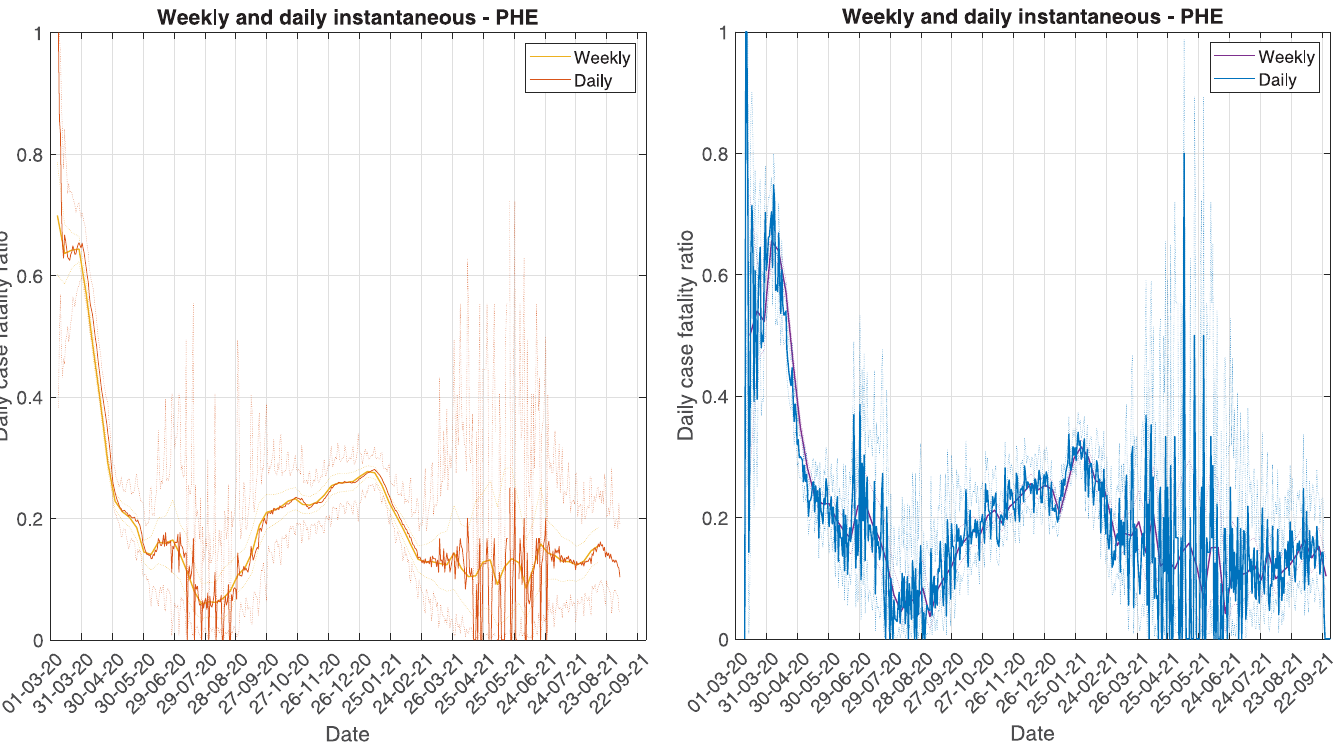
Fig 3. Comparing weekly instantaneous CFR to daily instantaneous CFR, using PHE data. Left panel shows the forward methods and right panel shows the backward methods.